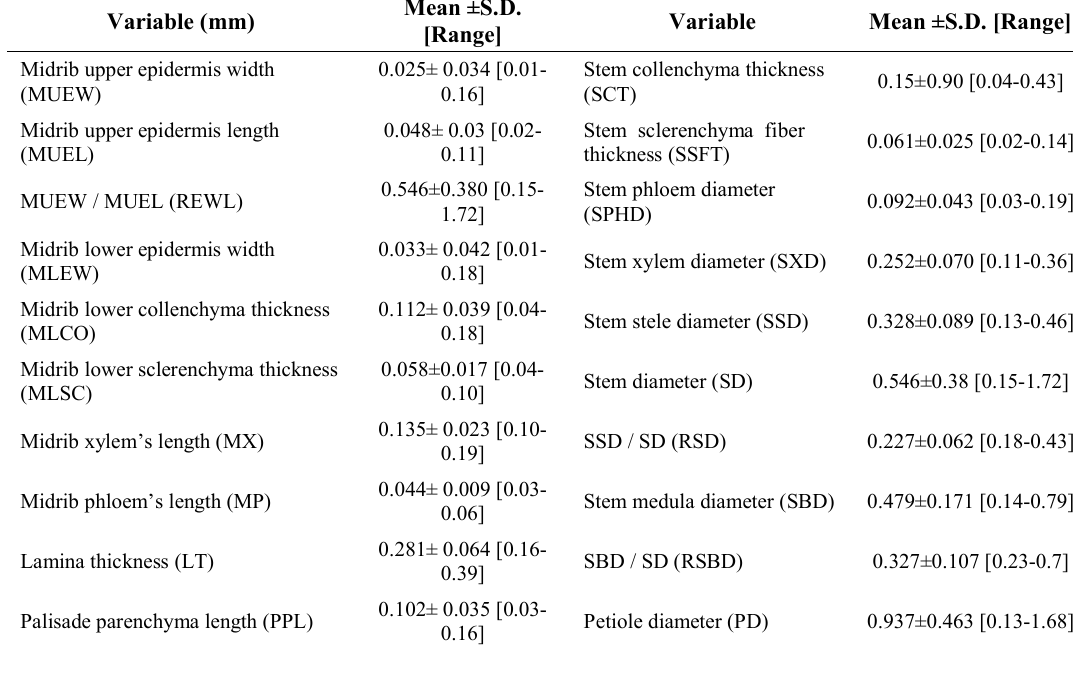
Table 2. Descriptive data for quantitative characteristics used in the statistical